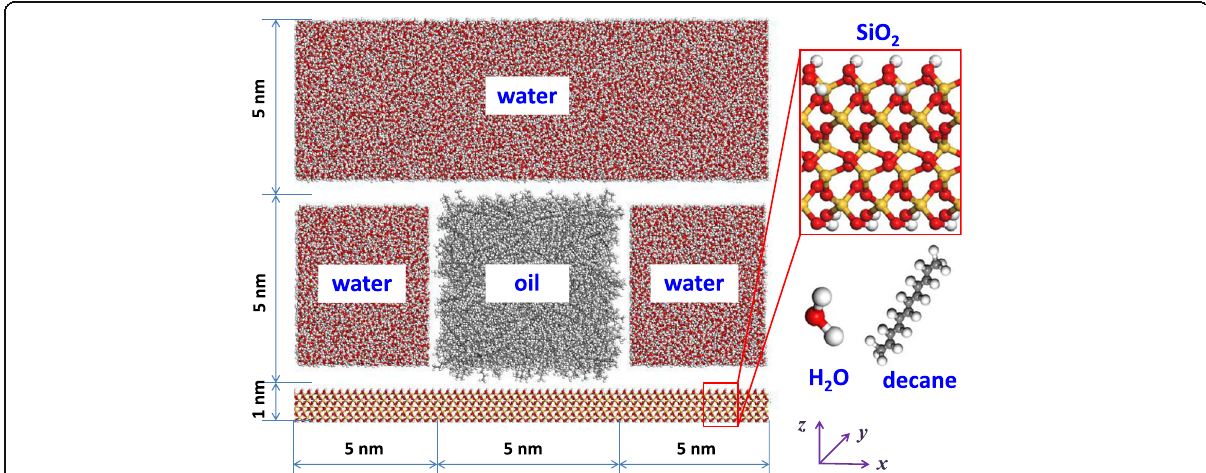
Fig. 1 Schematic illustration of the simulation system. Side view of the simulation system with an oil cube surrounded by water on the top of silicon dioxide substrate (left) and atomic views of decane and water molecules